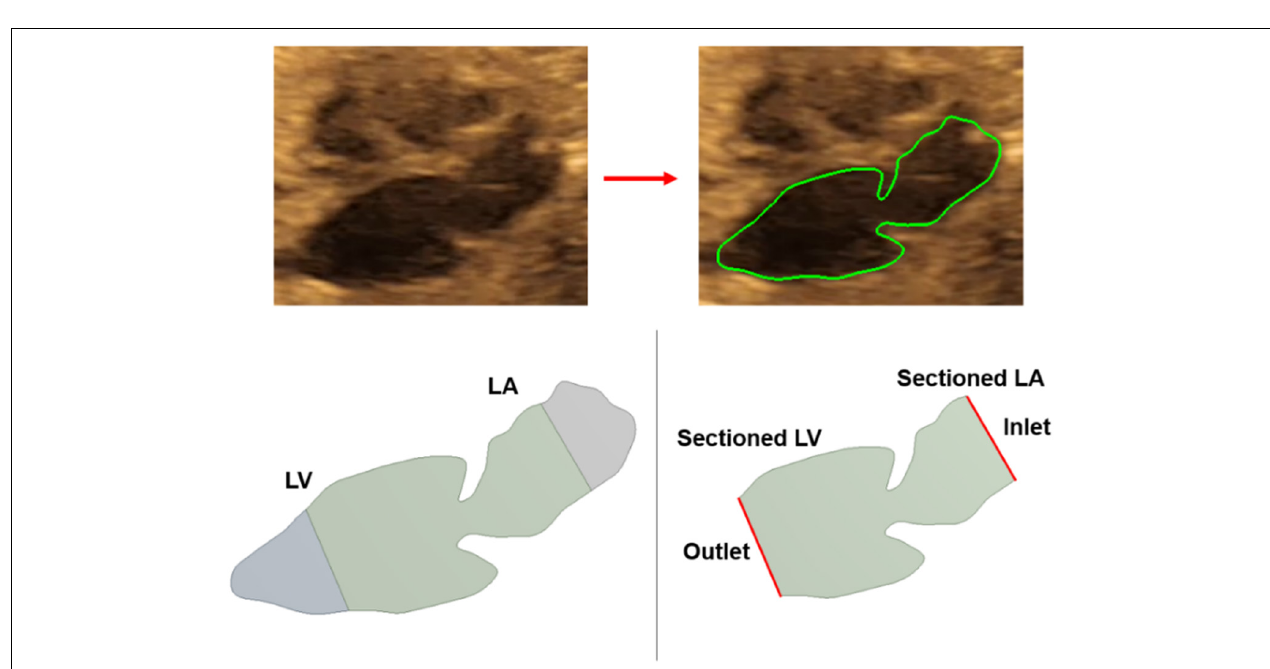
FIGURE 3 | Medical image of a sample fetal heart and defining the boundary layers. About one third of the left ventricle and left atrium are removed from the outer edges. The inlet and outlet flow boundaries are defined at the sectioned regions.